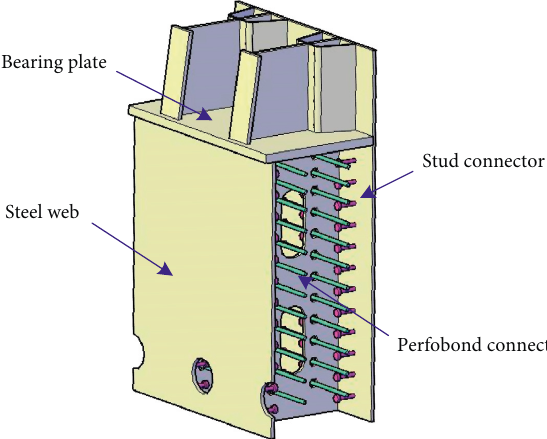
Figure 3: The structure detail of the steel cell in the hybrid joint.